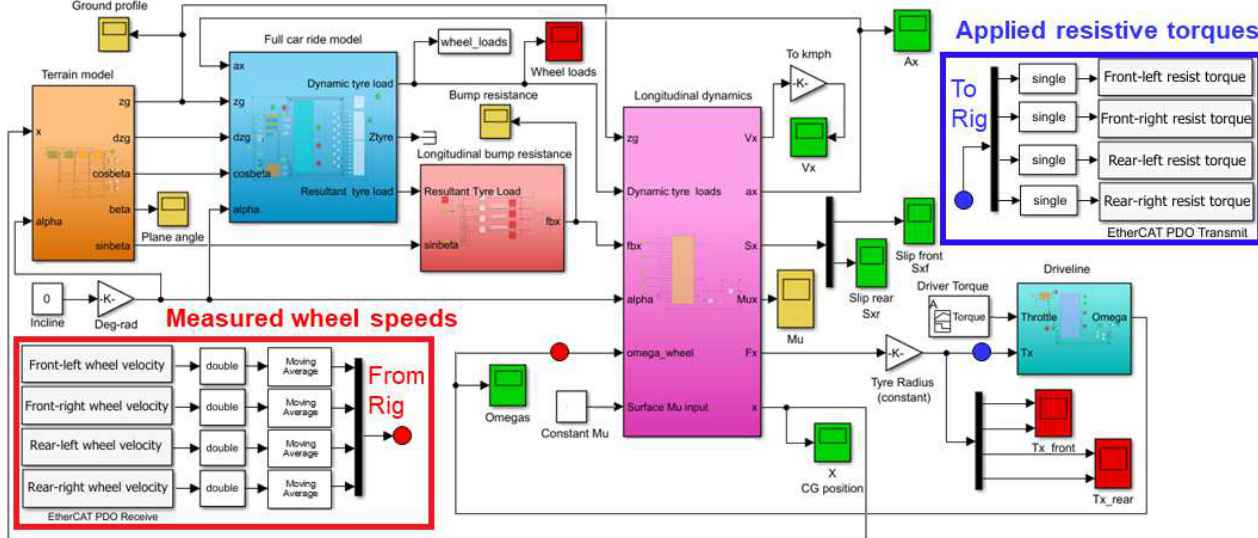
Fig. A.1. Offline and rig models developed in MATLAB/Simulink